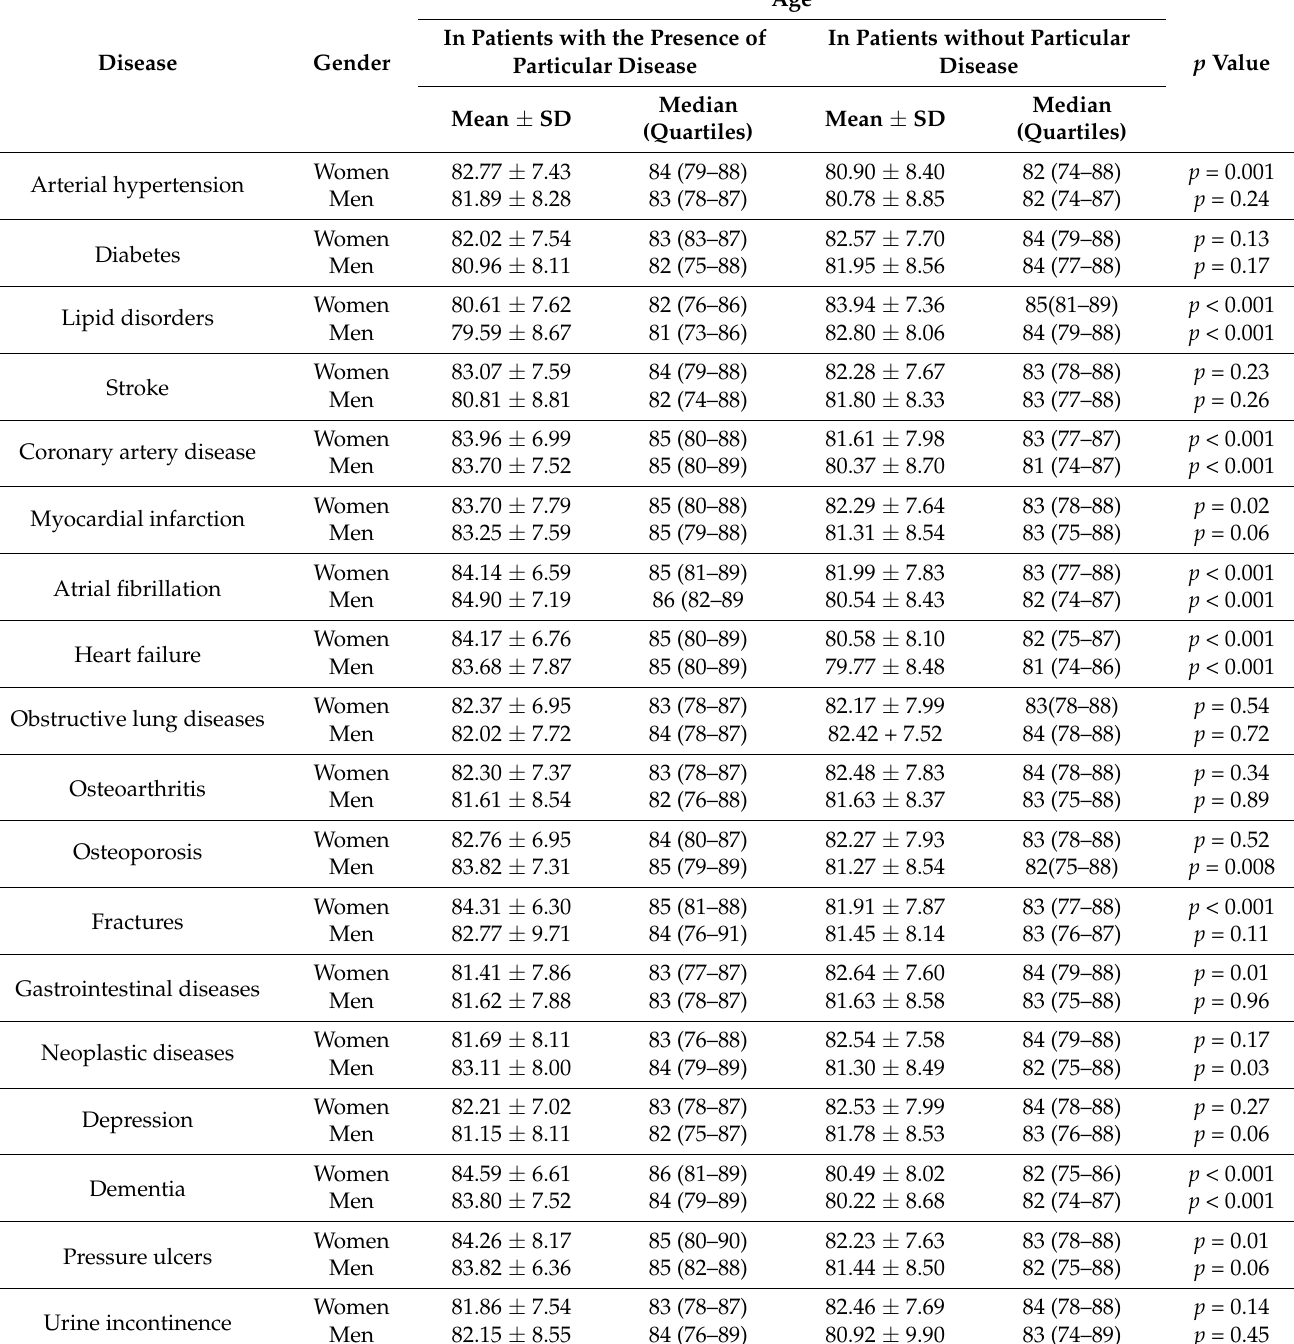
Table 3. Comparison of age according to the prevalence of